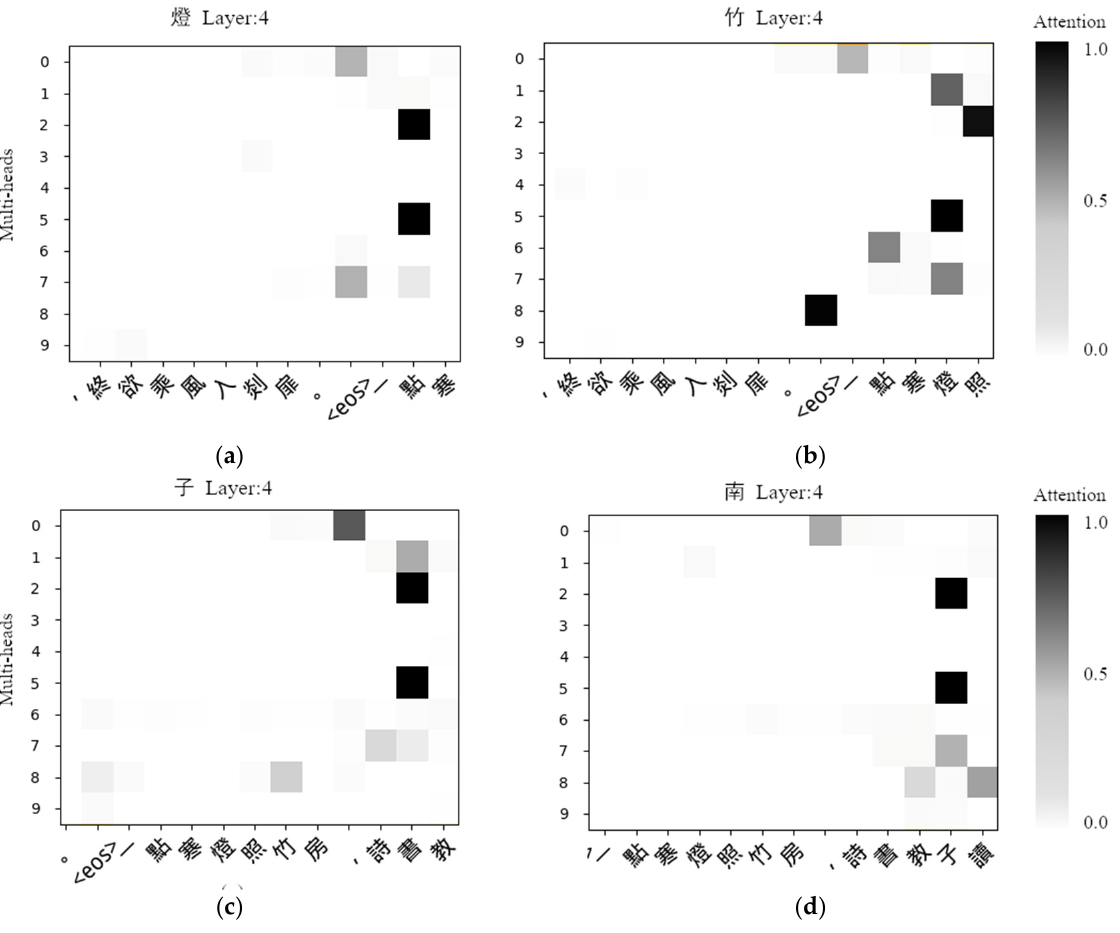
Figure 7. Visualization of the alternative-rule. The grey squares represent the attention score and the darker the color, the larger the score. ( a ) lamp ( 燈 ); ( b ) bamboo ( 竹 ); ( c ) son ( 子 ); ( d ) south ( 南 ).